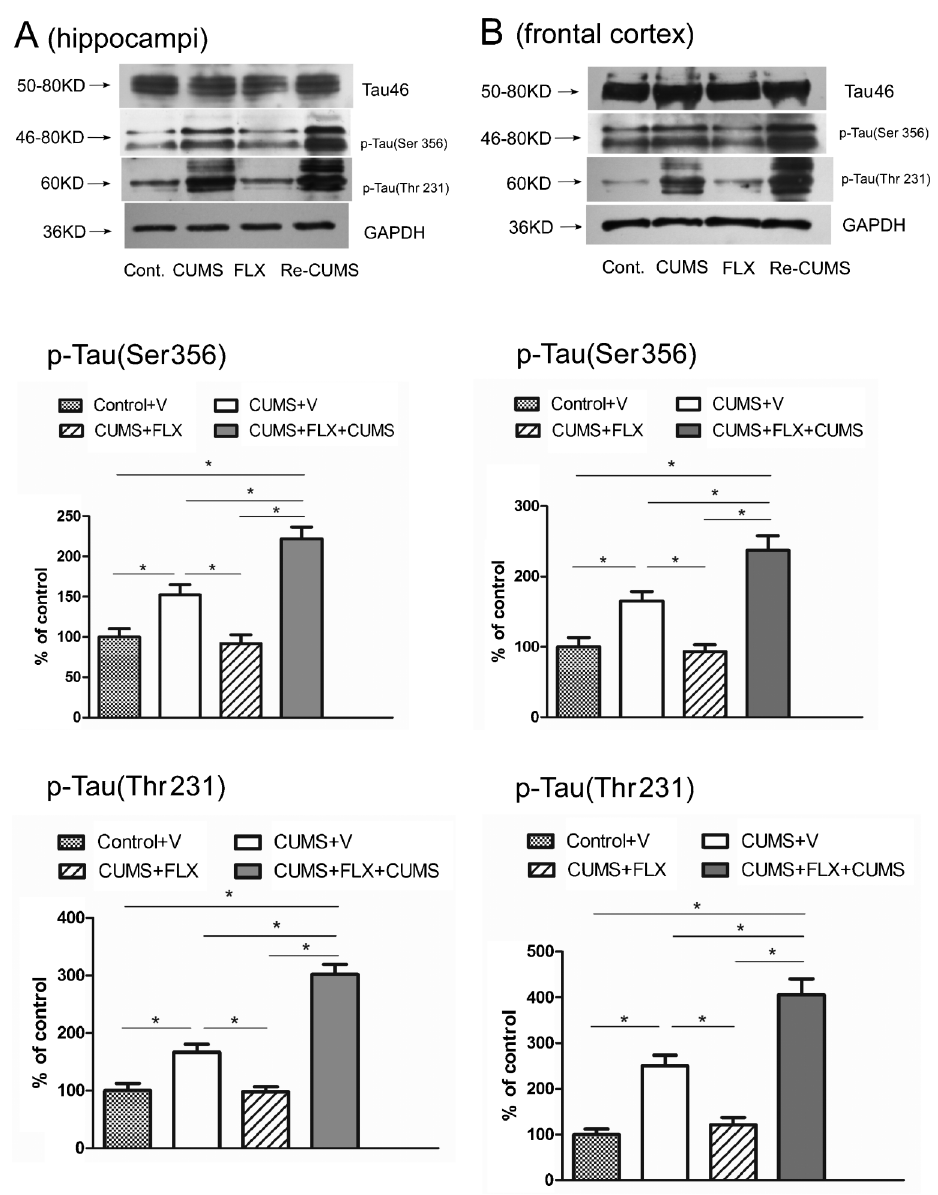
Figure 3. Effects of chronic unpredictable mild stress (CUMS), fluoxetine (FLX), and re-exposure to CUMS on the levels of tau and phospho-tau in the hippocampi and the frontal cortex of rats. GAPDH was used to normalize the quantification in Western blot experiments. Representative Western blot bands of the hippocampi ( A ) and the frontal cortex ( B ) and densitometric analyses of the bands for p-Tau (Ser356) and p-Tau (Thr231) ratio of the hippocampi, and p-Tau (Ser356) and p-Tau (Thr231) ratio of the frontal cortex. Cont: Control++vehicle (V); CUMS: CUMS++V; FLX: CUMS++FLX; Re-CUMS: CUMS++FLX++CUMS. Data are reported as means±SD. *P , 0.01 (one-way ANOVA followed by the Bonferroni